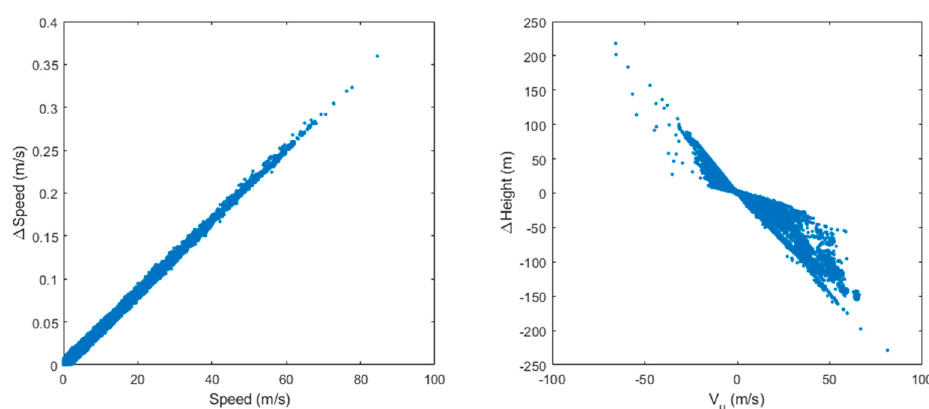
Figure 28. Retrieved wind speeds and heights are affected by the presence of a +10 s time assignment error in the B+ scene roughly in proportion to the speed. The graphs plot the differences between retrievals with and without the time bias applied to the B+ scene. The left panel shows the speed error versus wind speed and the right panel shows the height error versus the u -component of wind.